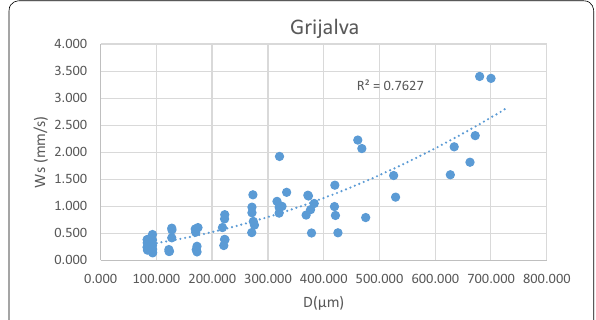
Fig. 11 PTV Measured values of Ws (blue points) and values estimated by Eq. 3 for the Grijalva river